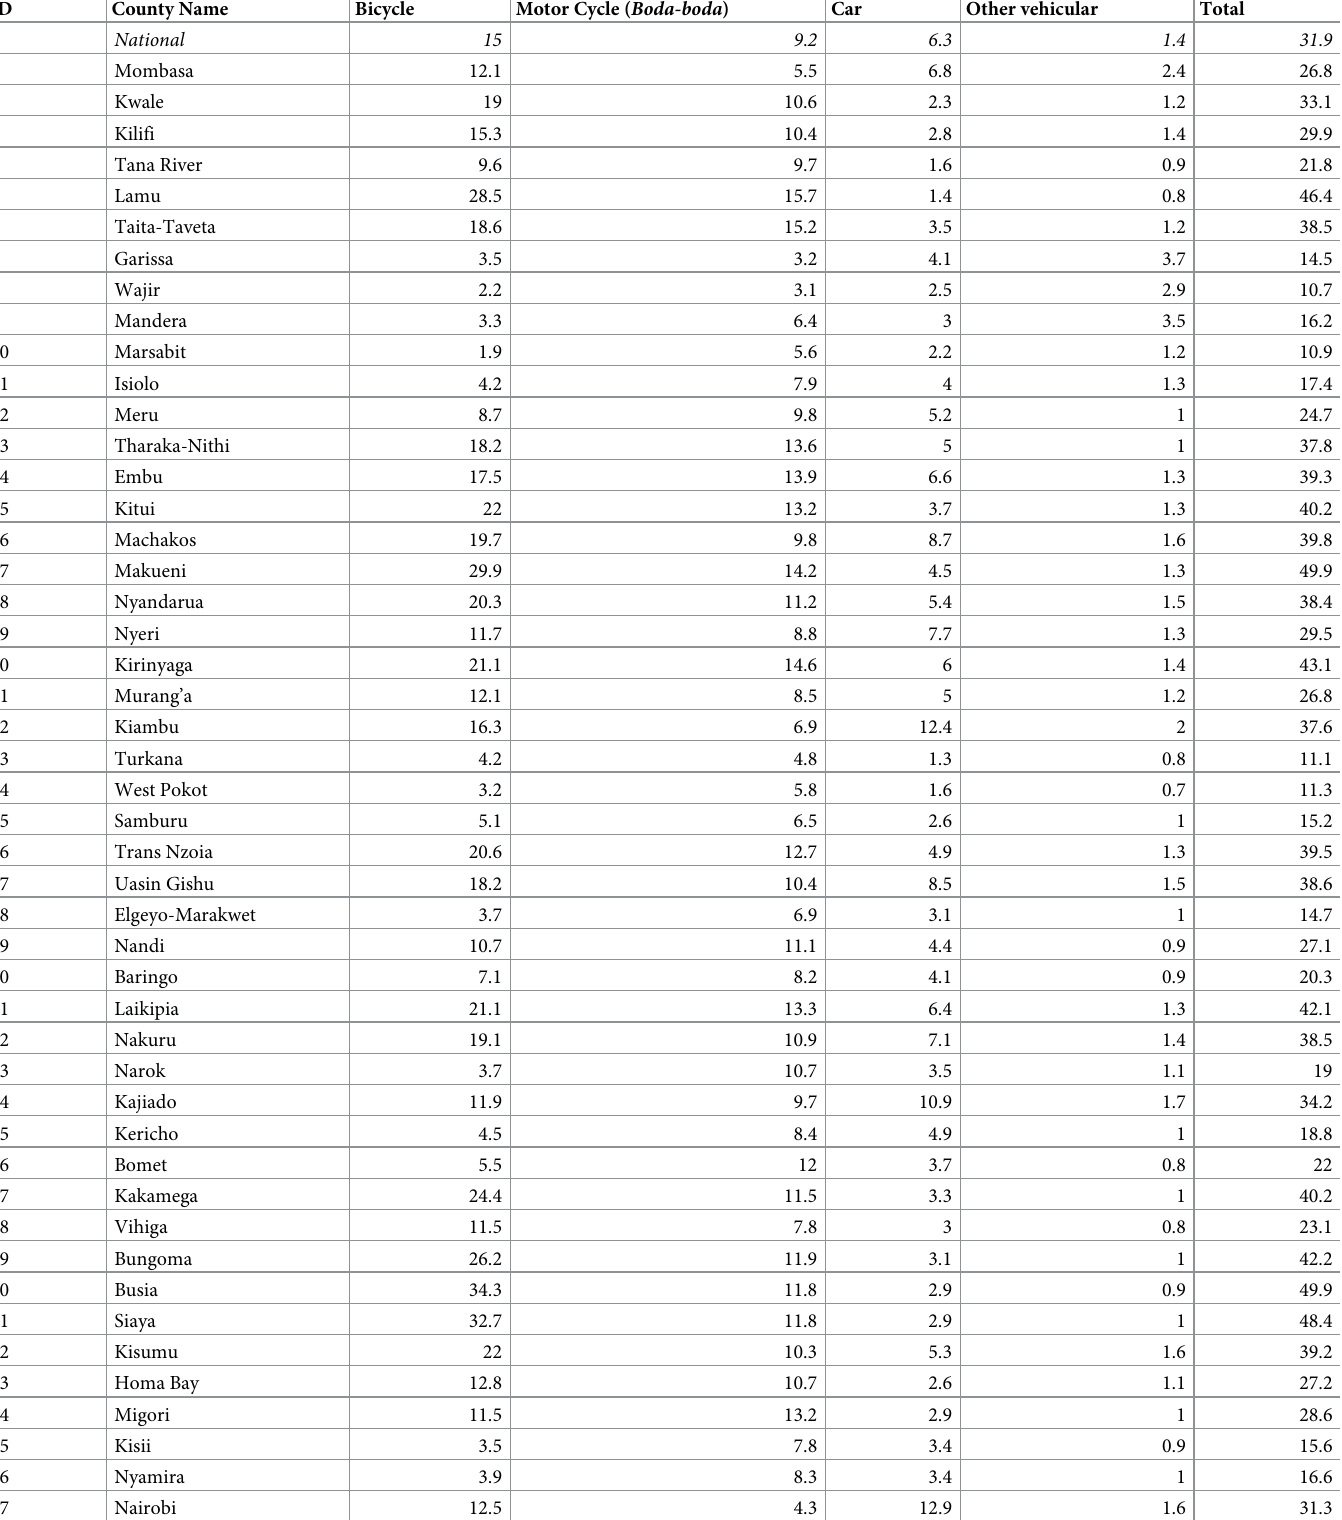
Table 1. Percentage distribution of households by ownership of bicycles, motorcycles, cars and other means of vehicular transport (truck, lorry, bus, three-wheeler truck, and tuk tuk ) by county [61].